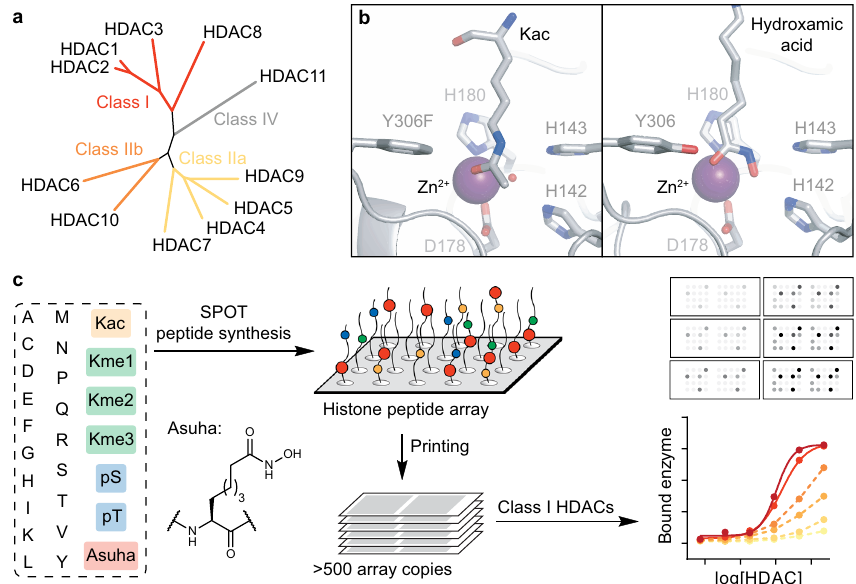
Fig. 1 Hydroxamic acid-modi fi ed microarrays for the direct capture and detection of class I HDAC isozymes. a Phylogenetic relationship of the 11 human Zn 2 + -dependent HDACs. b X-ray co-crystal structures showing the binding pocket of HDAC8 interacting with a Kac-containing peptide substrate or a hydroxamic acid. In contrast to Kac (left, PDB: 5DIC, Y306F mutation required for deactivation), hydroxamic acids (right, PDB: 3EW8) stall the transient interaction by chelating the Zn 2 + ion in the active site. c Work fl ow. Peptide microarrays are prepared using the appropriate hydroxamic acid-containing aminosuberic acid analog (Asuha). Resulting arrays allow for the direct assessment of HDAC isoform-speci fi c binding. Kme1, Kme2, Kme3: ε - N -mono-, di-, and trimethyllysine; pS: O- phosphoserine; pT: O- phosphothreonine; Kac: ε - N